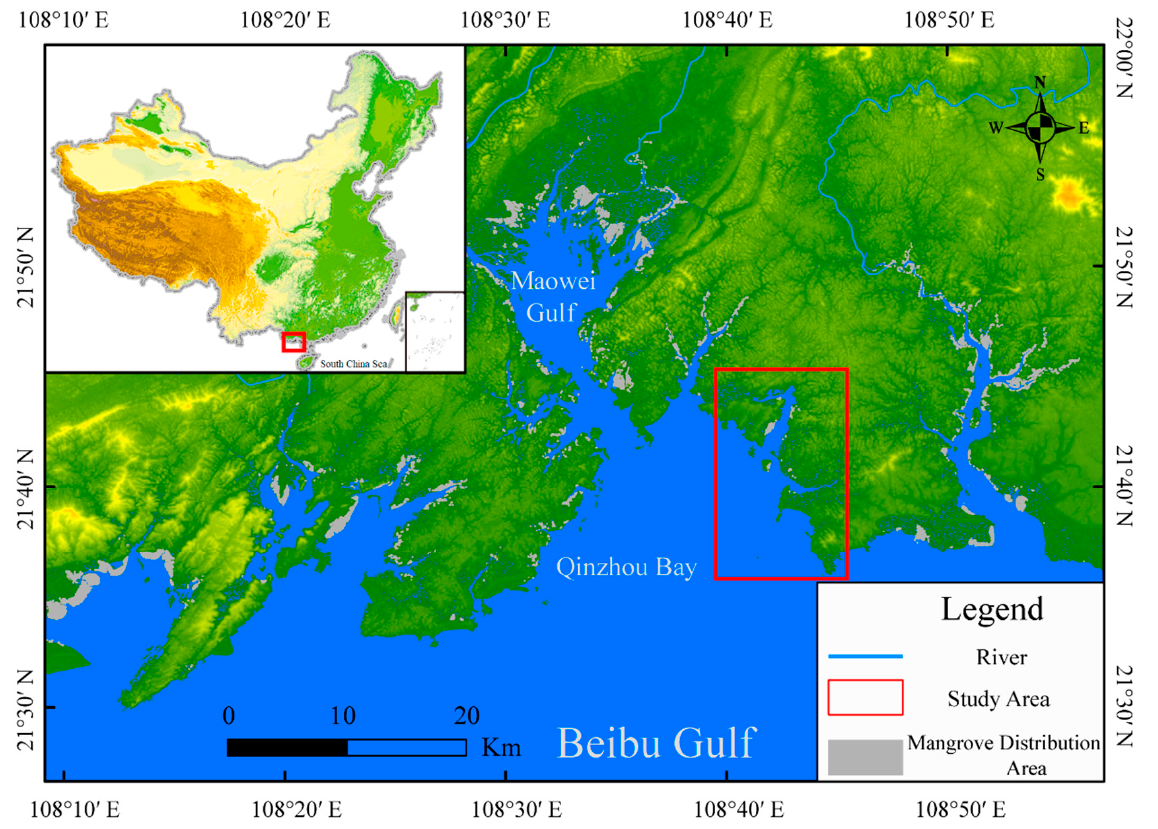
Figure 1. Geographical location and mangrove distribution area in the Lu’erhuan River Sea area of Qinzhou Bay, Guangxi Province. The red rectangle is the study area and the grey shaded areas are mangrove growth areas.